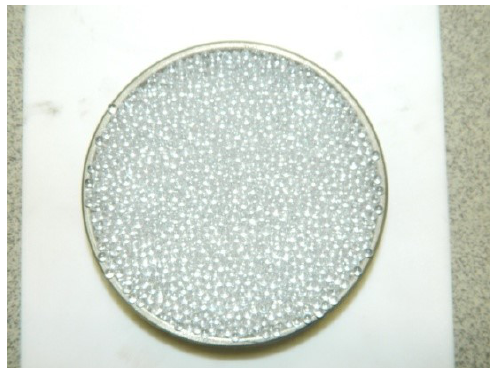
Figure 3: Image of the stored material